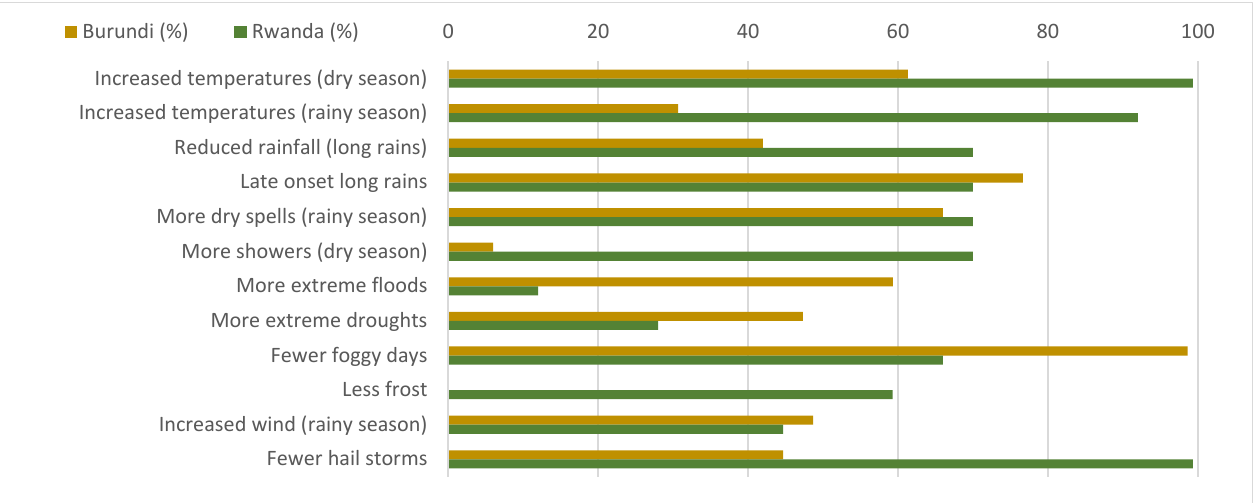
Figure 2. Observed changes in climate in terms of the percentage of respondents in each study area (Burundi n = 150, Rwanda n = 150). Note that we did not ask about reduced rainfall during the short rains, but some respondents in both countries mentioned such changes, something which requires further